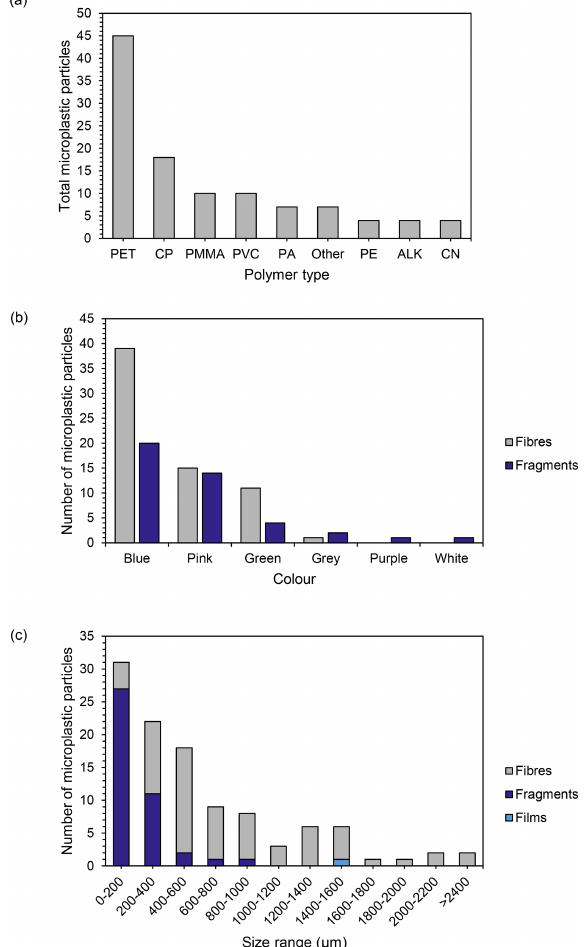
Figure 4. Polymer types identified across all samples. (a) Num- ber of each polymer type found across all Antarctic study sites (PET: polyethylene terephthalate; CP: copolymers; PMMA: poly- methyl methacrylate; PVC: polyvinyl chloride; PA: polyamide; other: polytetrafluoroethylene (PTFE), polyvinylidene, polypropy- lene, silicone and polymethyl anhydride; PE: polyethylene; ALK: alkyds; CN: cellulose nitrate); (b) number of microplastic frag- ments and fibres identified in each colour category (films ( n = 1) excluded); (c) size distribution of microplastics across all samples categorized by morphotype (length).